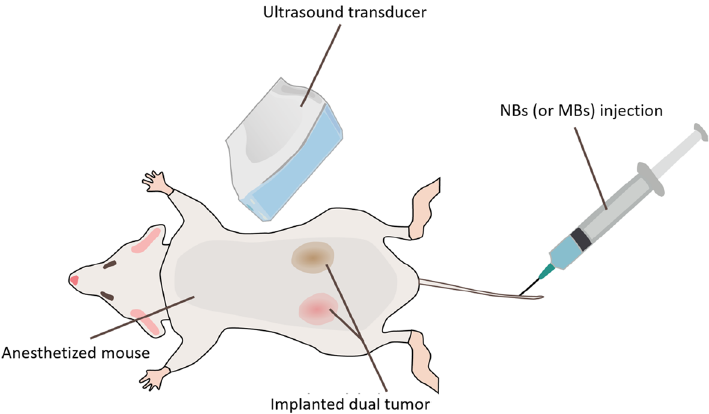
Figure 1. Schematic illustration of the experimental setup. The male athymic nude mice were anesthetized before acquiring CEUS images. A dual tumor was implanted in each mouse subcutaneously in each limb. The ultrasound transducer was fixated at a position at which both tumors were in the field of view. CEUS imaging was performed by administering a 200-μL bolus of NBs (or MBs for reference) via the tail